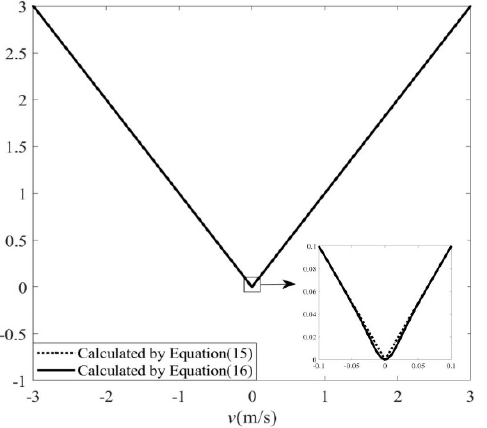
Figure 4. Comparison between Equations (15) and (16).